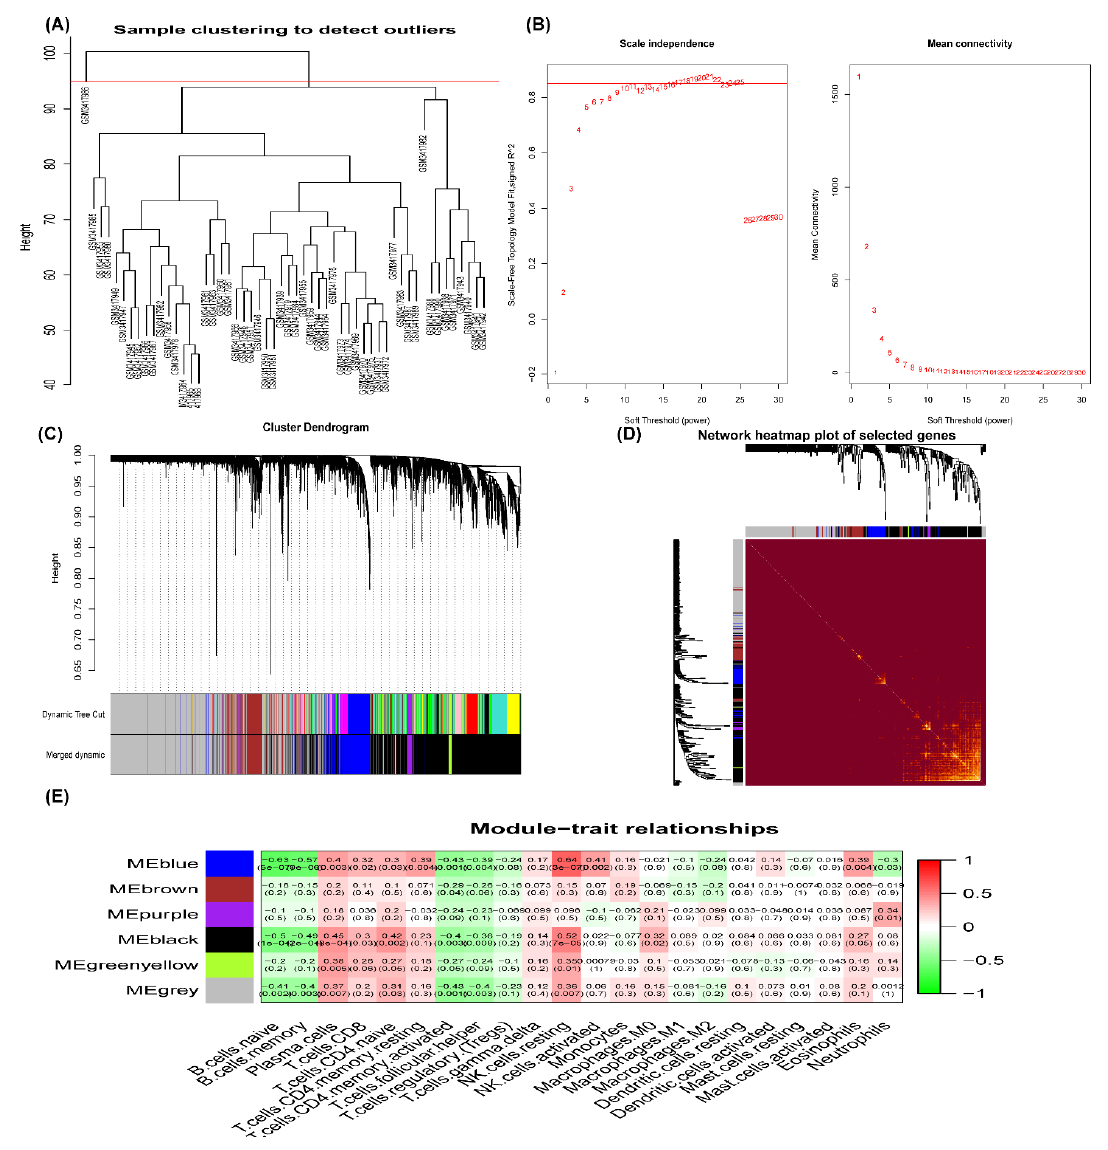
Figure 5. Weighted gene coexpression network analysis (WGCNA) for GSE120895. ( A ) The sample clustering to detect an outlier. ( B ) Analysis of the scale-free index (left) and mean connectivity (right) for various threshold powers. ß = 17 (scale-free R 2 , 0.85) was chosen as the soft threshold. ( C ) Clustering dendrogram of genes, together with assigned module colors. Merge modules with a similarity of 0.85. ( D ) Network heatmap plot in the coexpression modules. Light color represents higher overlap. ( E ) Module–trait relationships; the numbers in the cell represent the correlation coefficient and corresponding p -value. The correlation coefficient is between −1 and +1, and the larger the absolute value, the stronger the association.